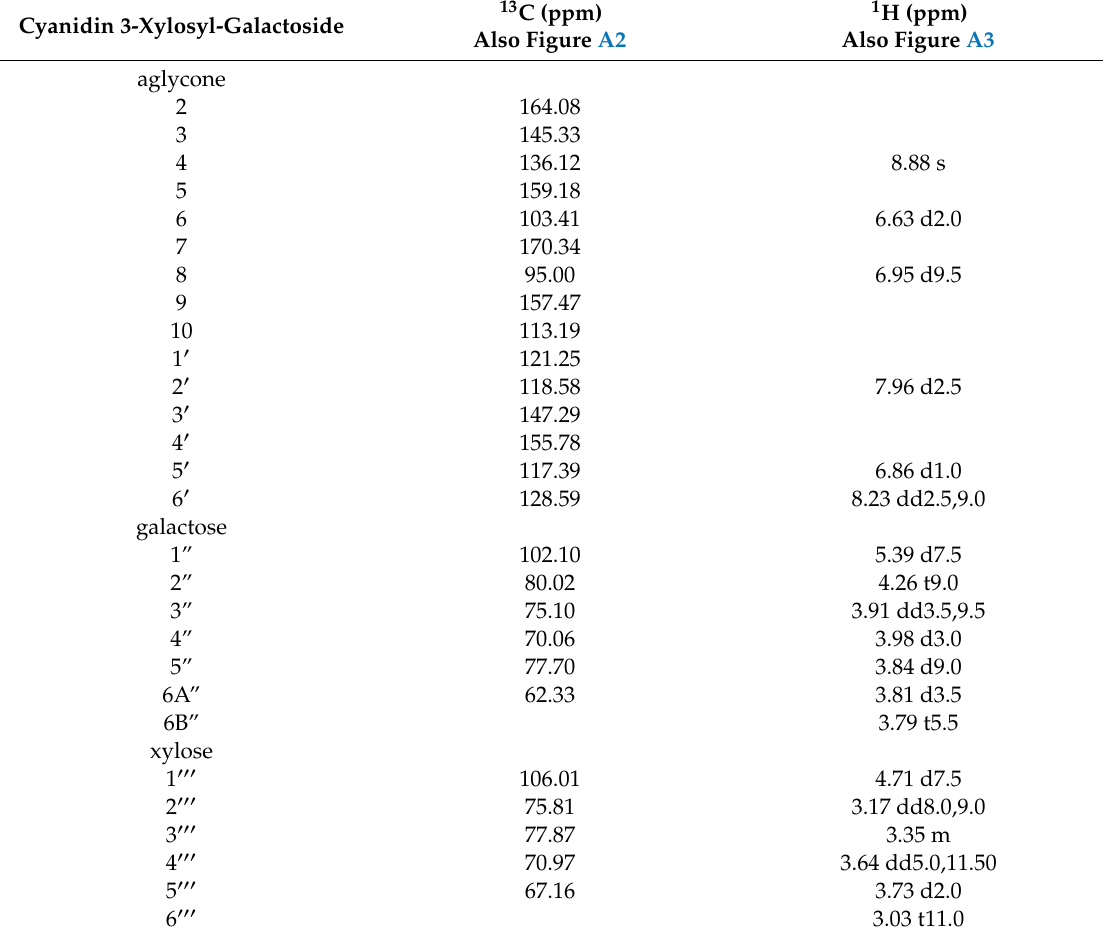
Table 1. 13 C and 1 H NMR spectral data (ppm) for cyanidin 3-xylosyl-galactoside. Cyanidin 3-Xylosyl-Galactoside